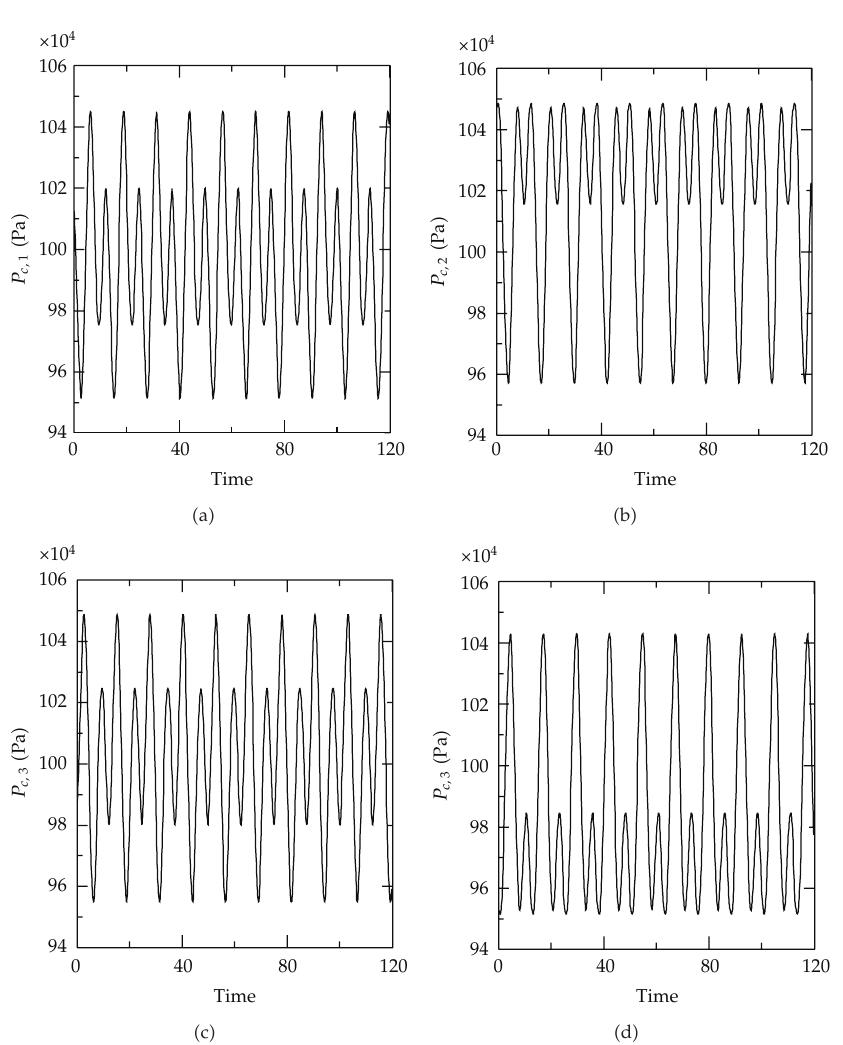
Figure 5: Pressure distribution in the static pressure chamber at s (cid:8) 2 . 6 (cid:2) without rub-impact e ff ect (cid:3) .